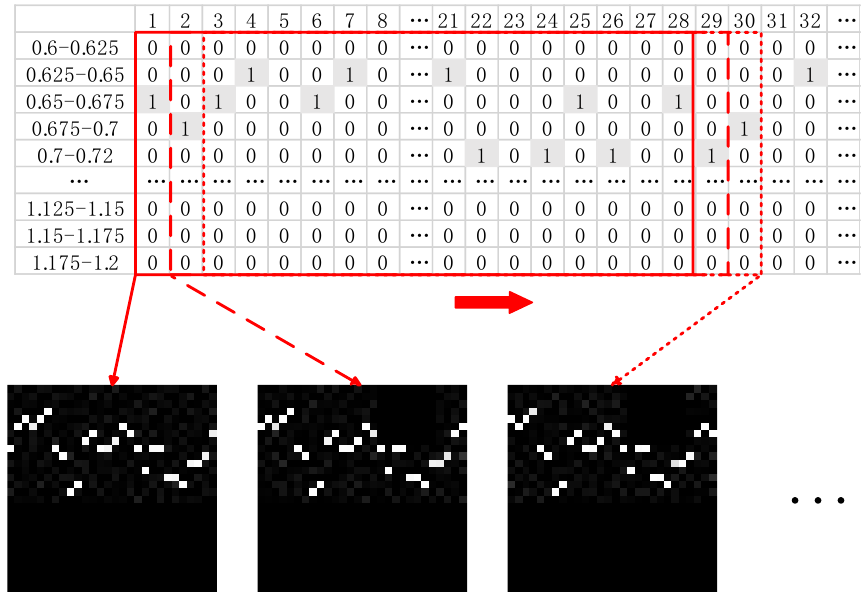
Figure 4. Data sets for the CNN model (number of interbeat intervals is 28).